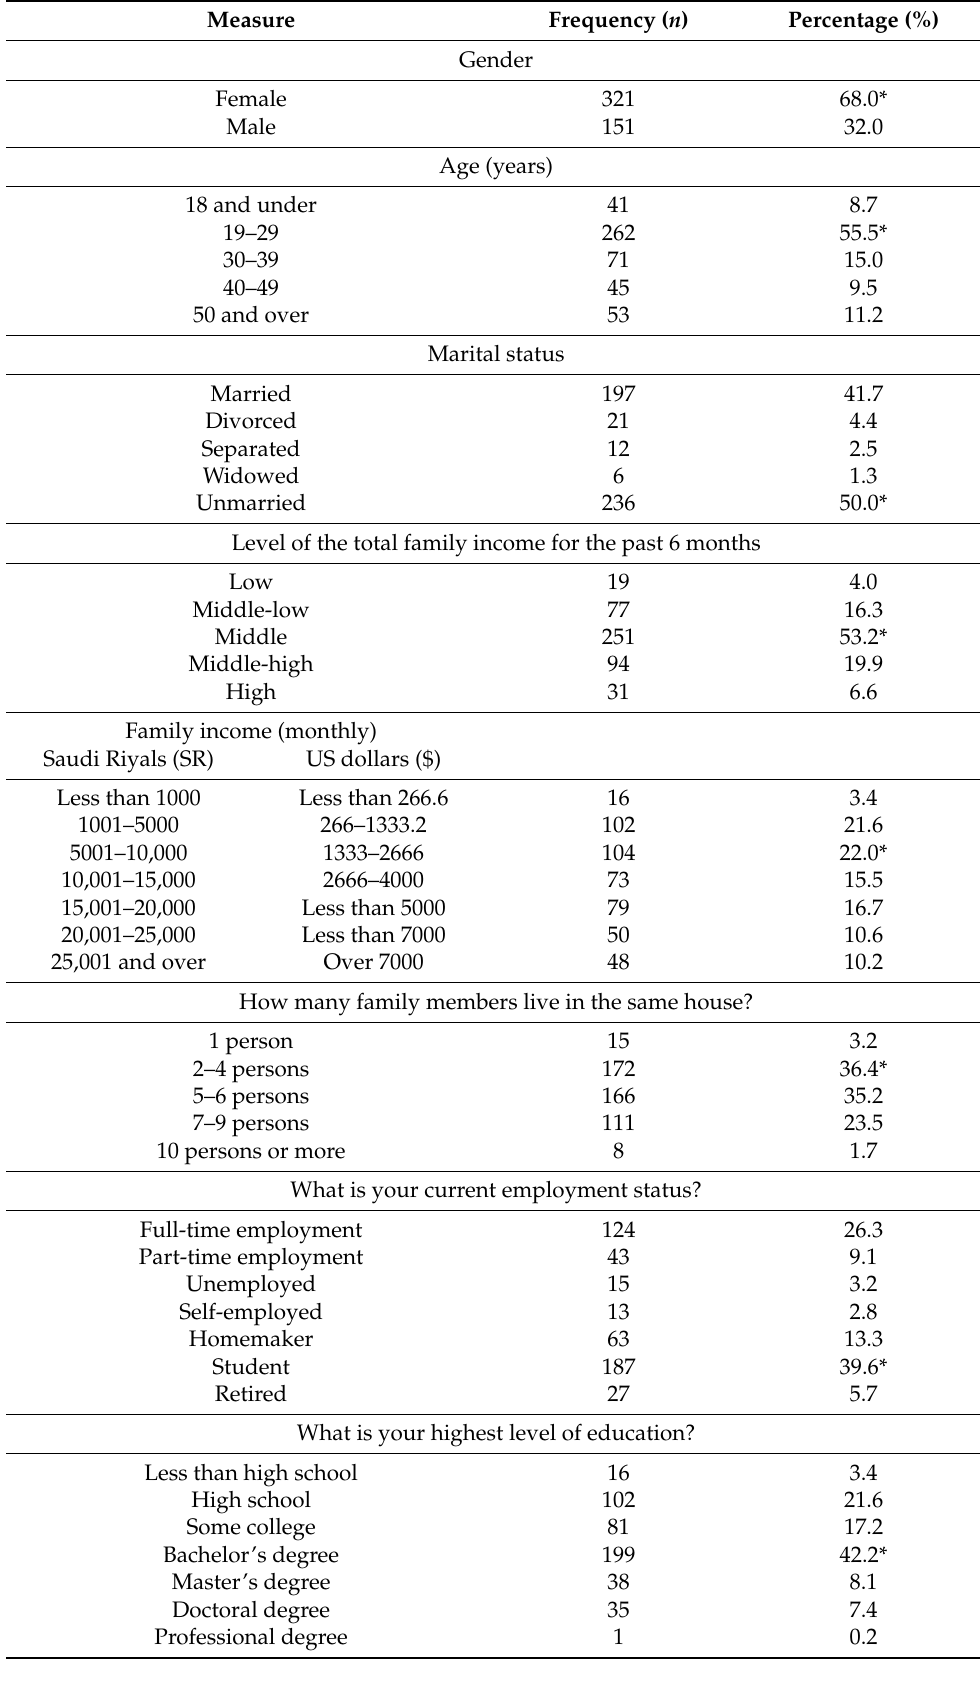
Table 1. Sociodemographic characteristics of the participants ( n =